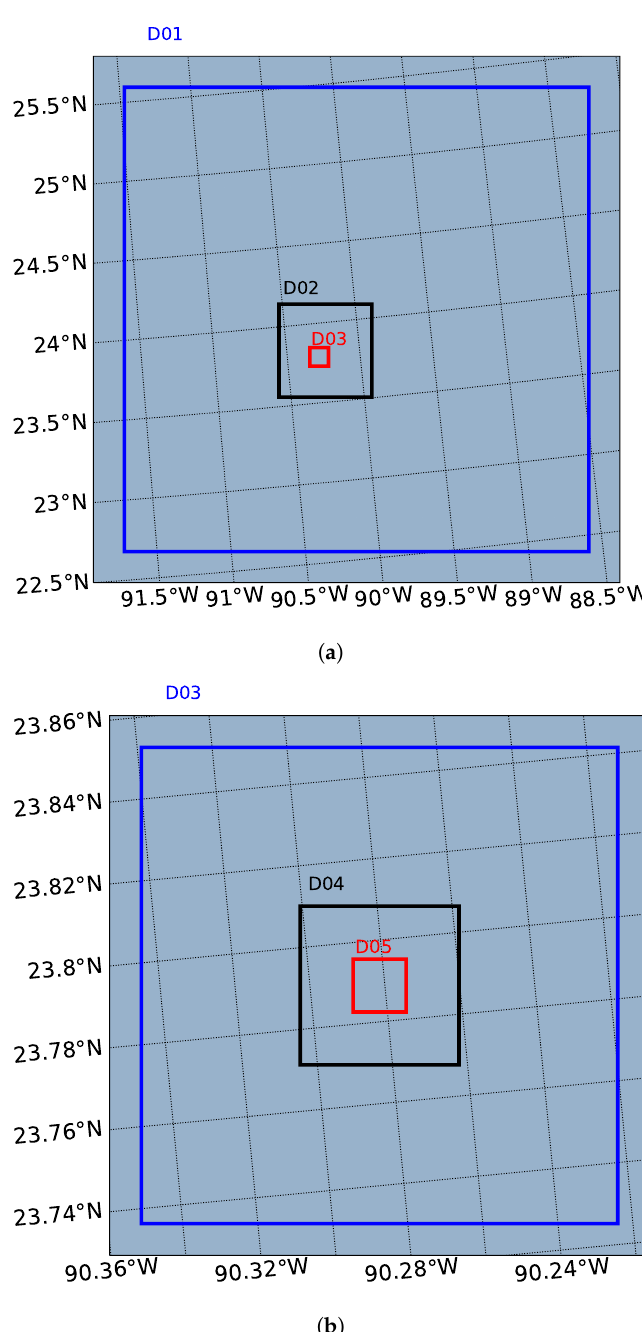
Figure 6. Overview of the atmospheric domain extents of ( a ) D01–D03, and ( b ) D03–D05 used in the surface ship wake